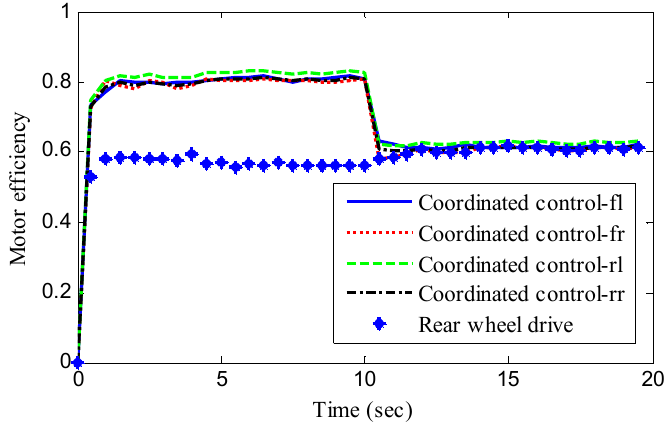
Figure 10. Motor efficiency in case study 1. Figure 10. Motor e ffi ciency in case study 1.